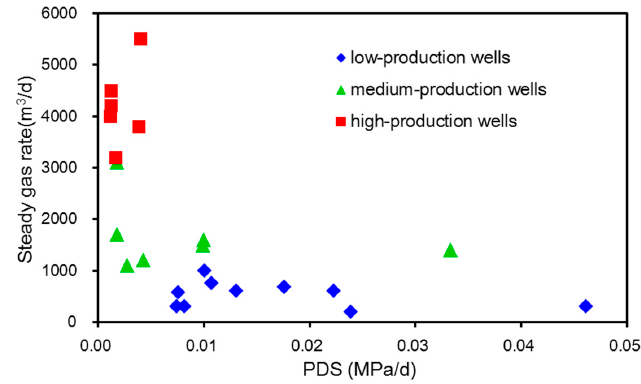
Figure 7. The relation between PDS and steady gas rate in water drainage stage. Water 2018 , 10 , x FOR PEER REVIEW